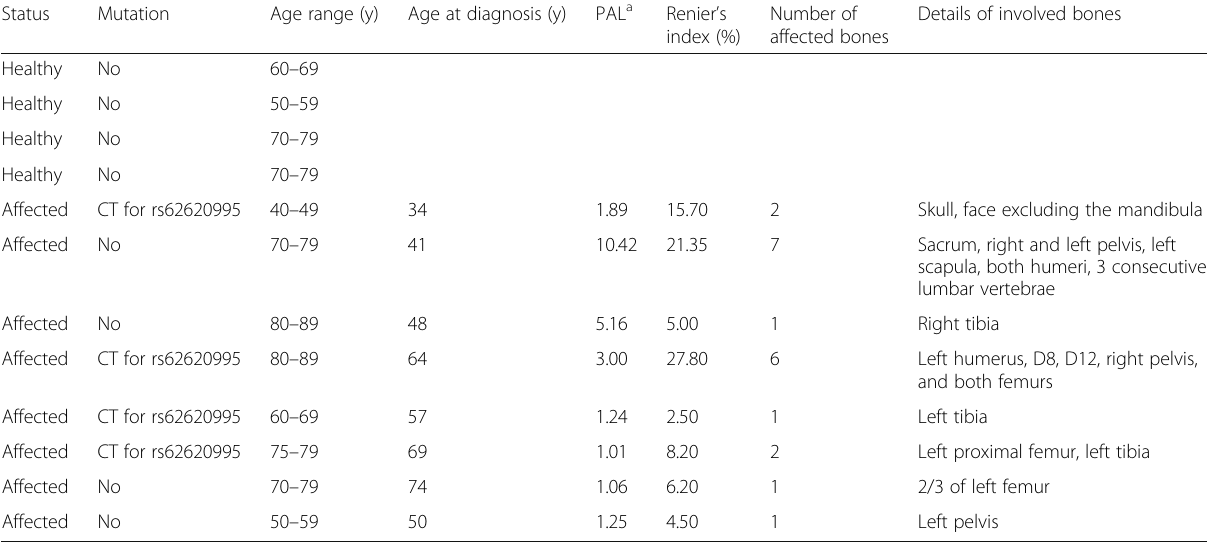
Table 1 Main clinical characteristics of study participants